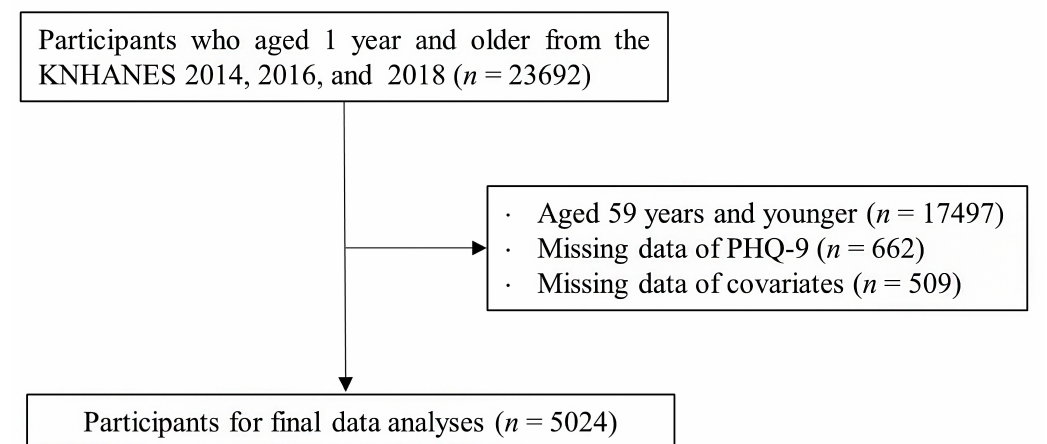
Fig. 1. Flow chart of selection for the study